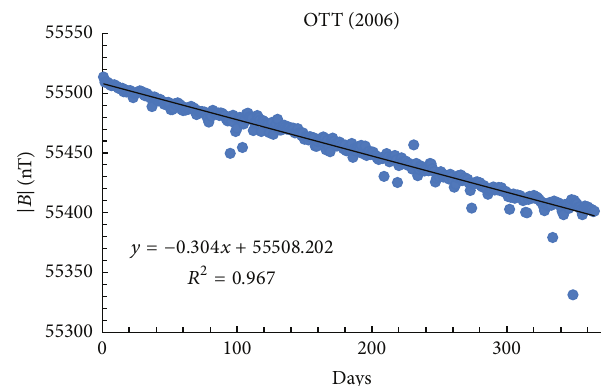
Figure 4: The dependence of the averaged value of MGF on the day order for OTT in